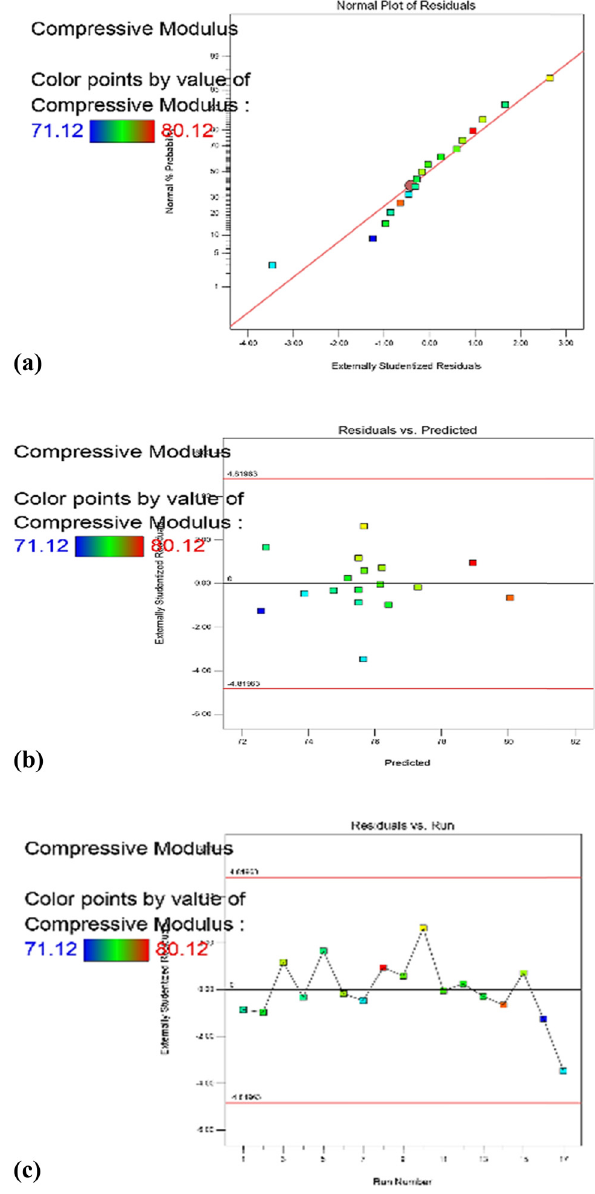
Figure 15: ( a ) Normal percent probability graph for compression modulus. ( b ) Residual vs predicted graph for compression modulus. ( c ) Residual vs run graph for compression